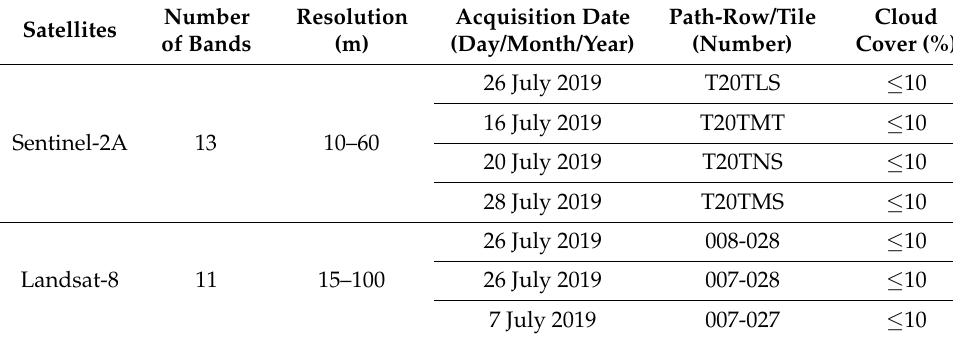
Table 1. List of satellite images used in the study.